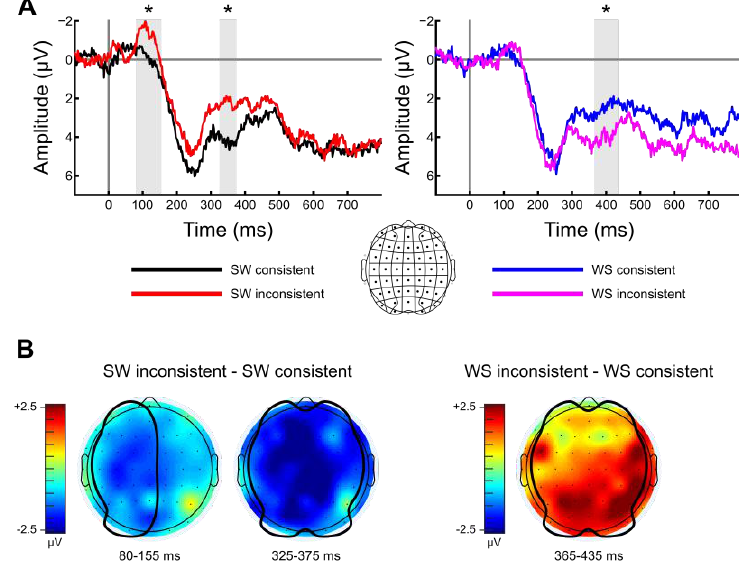
Figure 2. Event-related potential (ERP) results. ( A ) Effects of metric predictability on a grand average ( n = 18) waveform amplitude for strong–weak (SW) targets (left) and weak–strong (WS) targets (right). Temporal regions of interest identified in the cluster-based permutation analyses are highlighted in grey. Temporal regions of interest that revealed a significant ( p < 0.05) main effect of metric consistency in conventional ANOVA analyses are indicated with an asterisk. Waveforms are averaged over the 49 electrodes included in the ANOVA analyses; the 7 (anteriority) × 7 (laterality) grid arrangement used to model electrode position in all ANOVAs is shown in the inset. ( B ) Scalp maps showing the topography of mean amplitude differences between the inconsistent and consistent conditions within the two temporal regions of interest identified for SW targets (left), and the one temporal region of interest identified for WS targets (right). The scalp region over which a significant ( p < 0.05) main effect of metric consistency was observed within the specified time window is outlined in black for each scalp map.